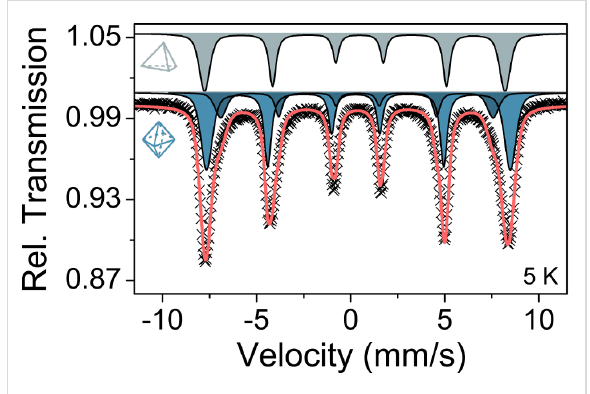
Figure 4: Low-temperature Mössbauer data of as-prepared ZFO nano- particles. The gray spectrum represents Fe 3+ on tetrahedral sites, while the blue spectra correspond to Fe 3+ residing on octahedral sites. The red line is the sum of the different sub-spectra.